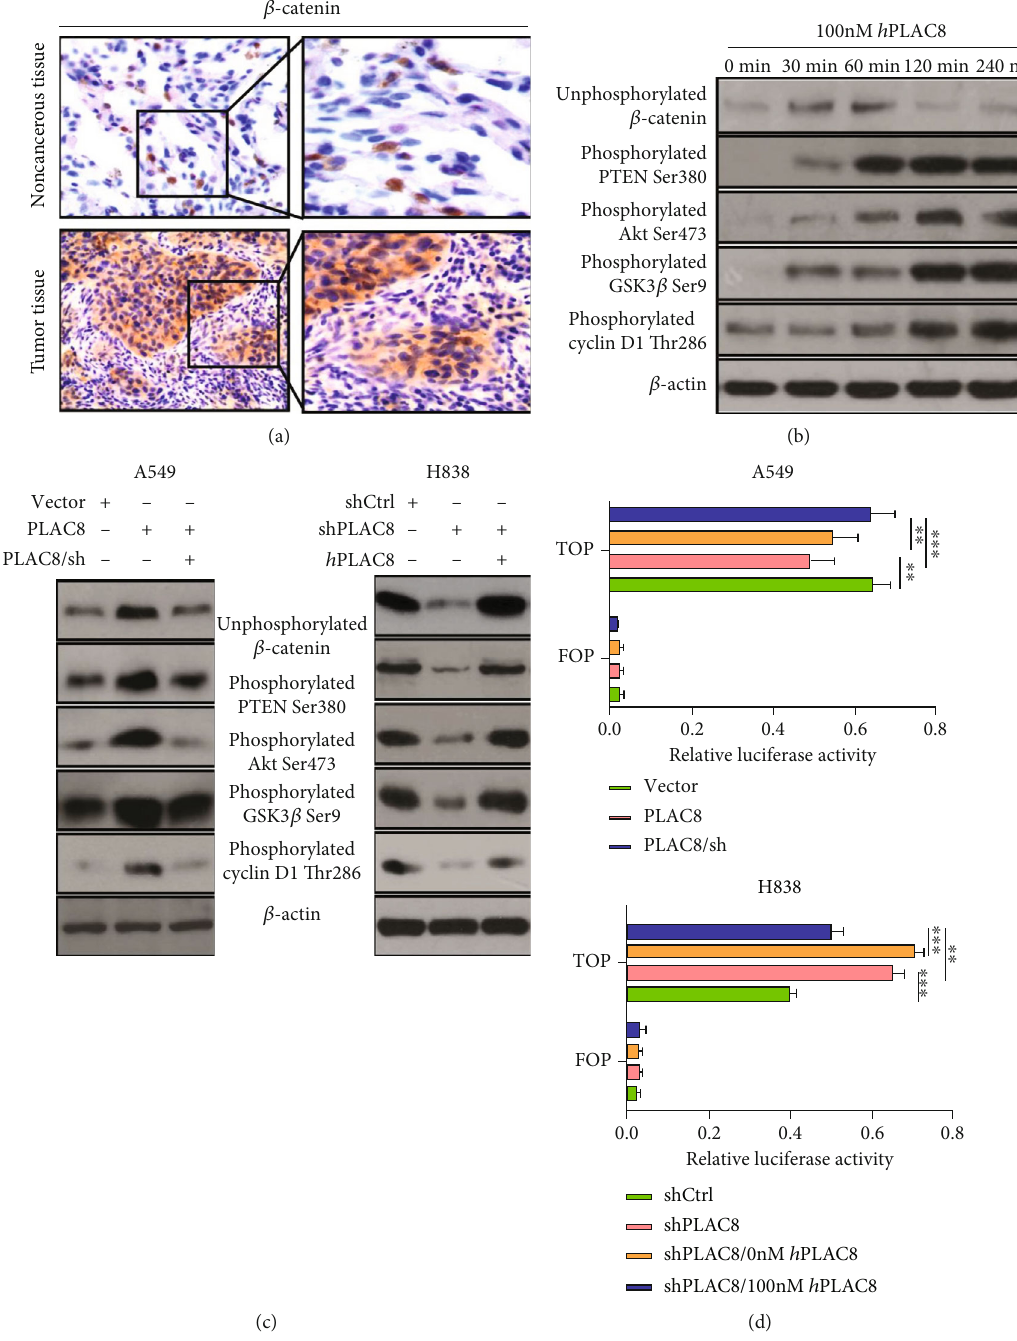
Figure 4: PLAC8 regulates lung cancer cell growth by regulating Wnt/ β -Catenin signaling pathway. (a) Expression of p-Catenin in lung cancer tissues and nontumor tissues. (b) Lung cancer cell were treated by 100ng/mL PLAC8 for the indicated times. (c) E ff ects of overexpression and downregulation of PLAC8 on Wnt/ β -Catenin signaling pathway (Western blot). (d) Dual luciferase reporter gene analysis reveals that PLAC8 regulates Wnt/ β -Catenin signaling pathway activity in A549 and H838 cells, ∗∗ p < 0 : 01 ; ∗ p < 0 : 001 . All these cell biological function assays were